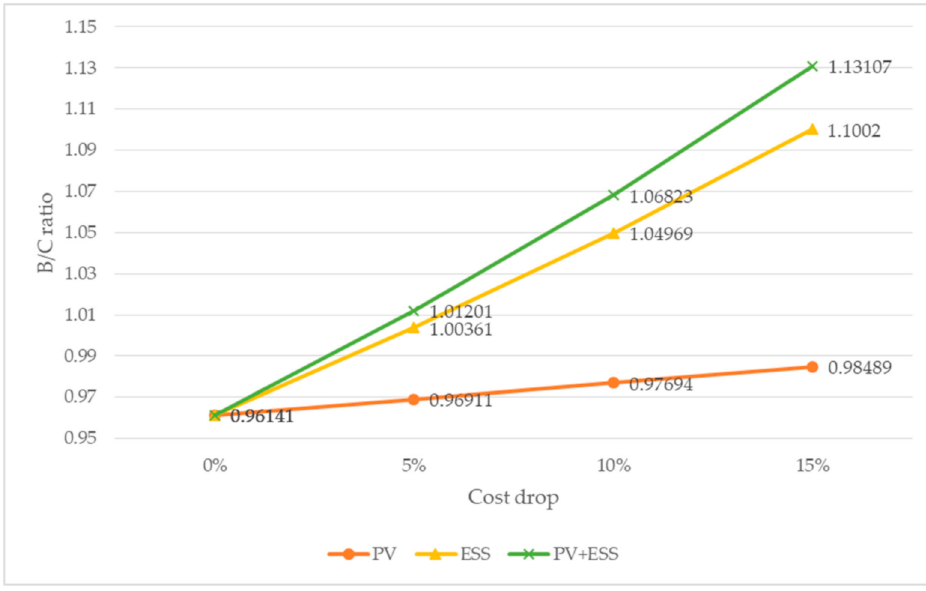
Figure 8. B/C changes owing to the equipment cost drop.